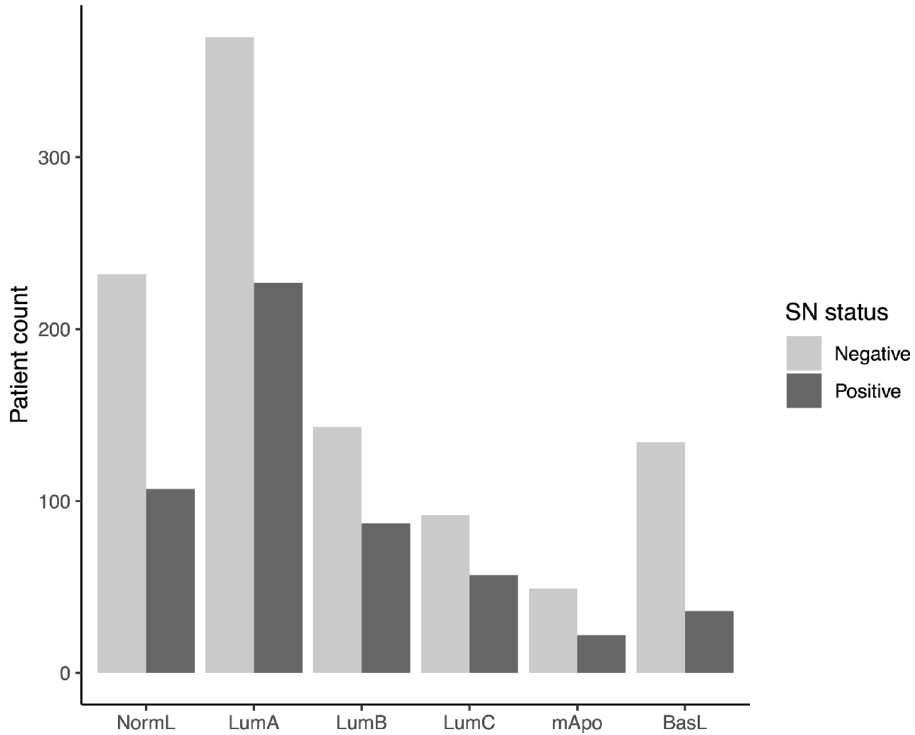
Figure 1. Distribution of molecular subtypes among the 1556 primary breast cancer patient samples > 10 mm and allocated for primary surgical procedure including a sentinel node (SN) examination. A total of 1020 patients had a SN-negative lymph node (pale grey) and 536 had a SN-positive lymph node (dark grey). The distribution of molecular subtypes (NormL, LumA, LumB, LumC, mApo, BasL) is illustrated at the x-axis and number of samples along the y-axis. Figure created using R 32 .